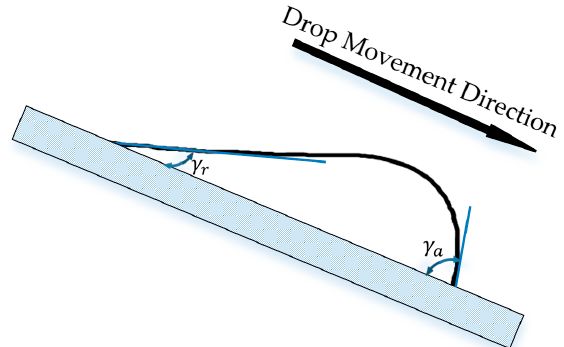
Figure 10. Contact angle hysteresis between advancing and receding contact angles (i.e., the raindrop effect), modified from [72].